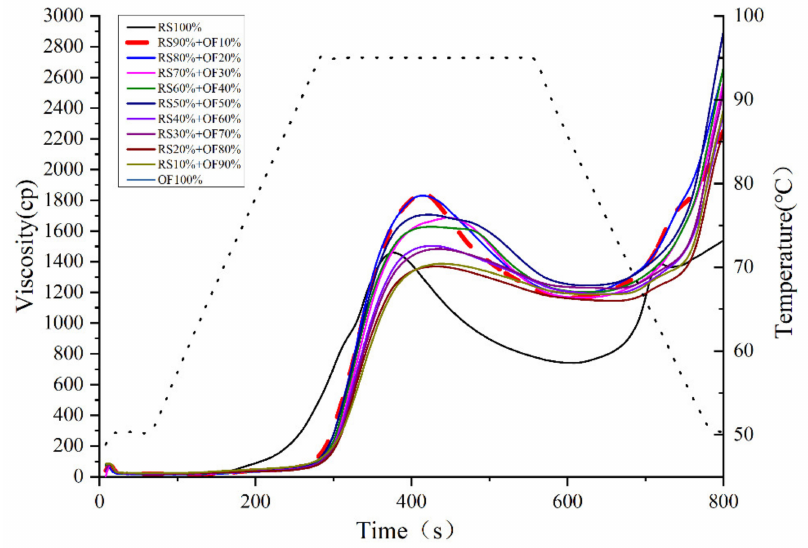
Figure 1. RVA gelatinization curve of rice starch (RS) and oat flour (OF) mixture system. Table 2. RVA gelatinization parameters of rice starch and oat mixture system. RS: rice starch; OF: oat